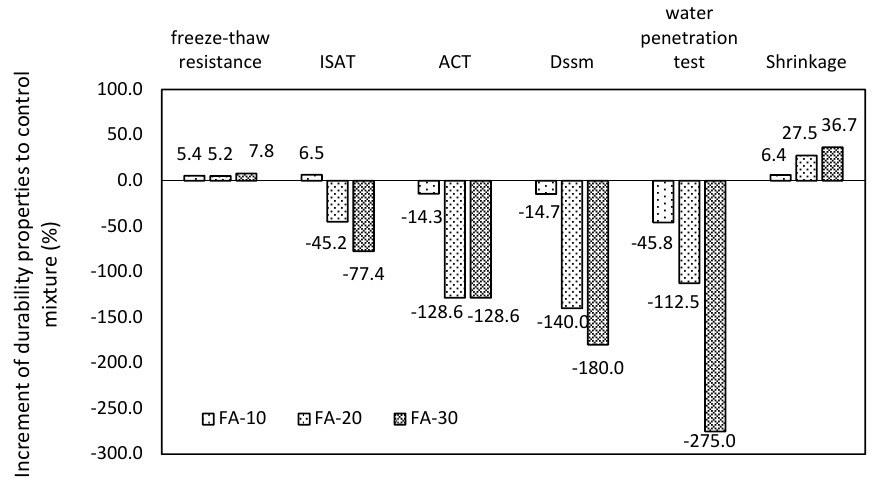
Figure 13. General changes in durability properties in comparison with the control mixture.